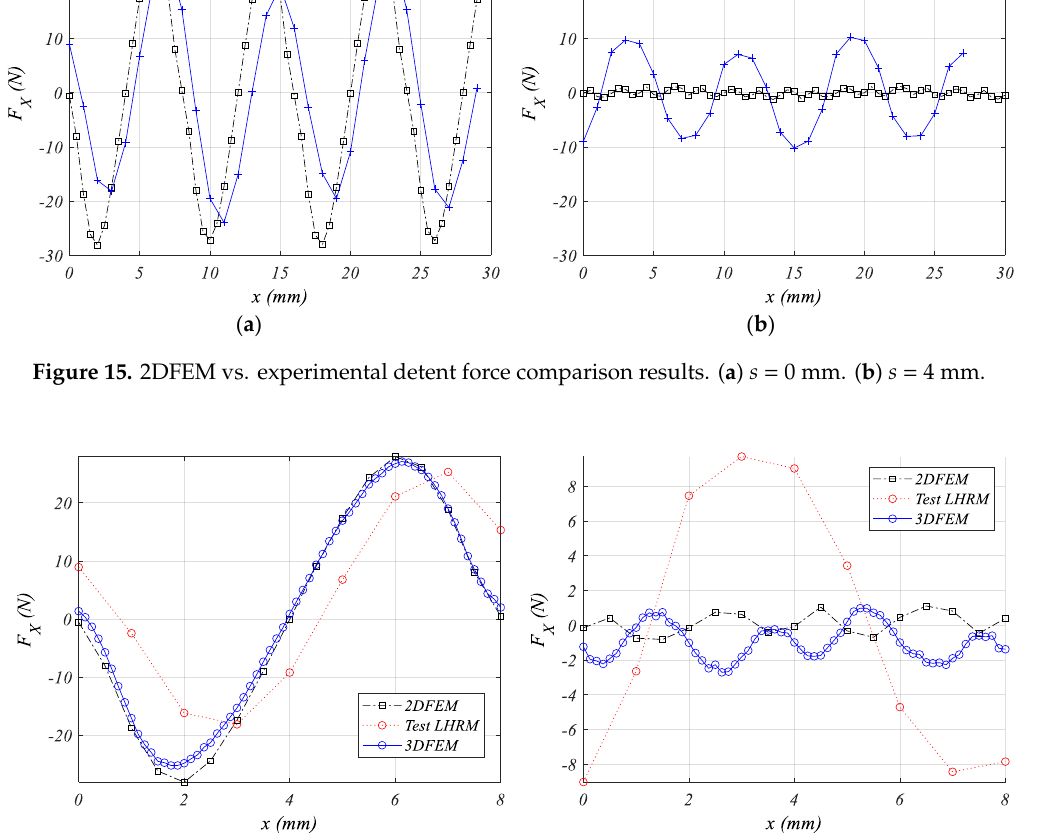
Figure 16. Detent force comparison results. ( a ) s = 0 mm. ( b ) s = 4 mm.